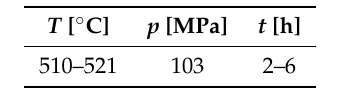
Table 1. Typical hot isostatic pressing (HIP) parameters for Al alloys